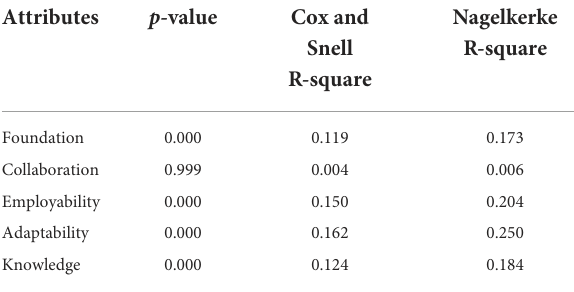
TABLE 2 Statistically significant results of the five logistics regression